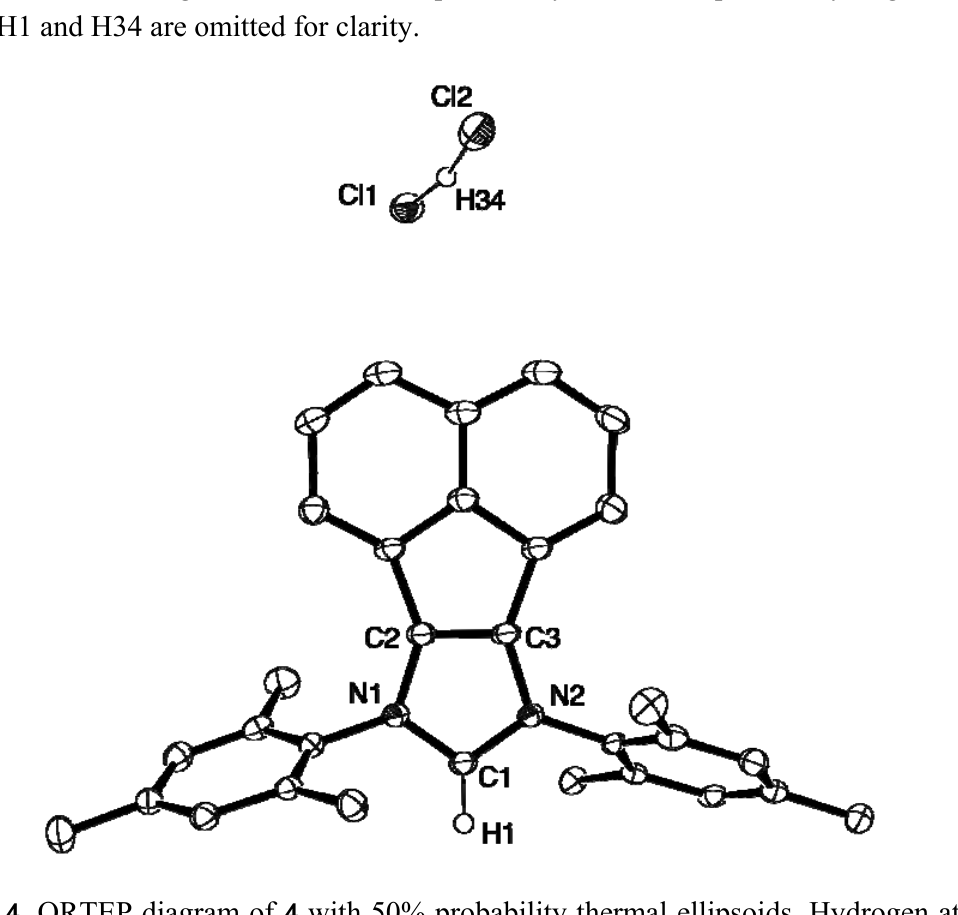
Figure 4. ORTEP diagram of 4 with 50% probability thermal ellipsoids. Hydrogen atoms except H1 are omitted for